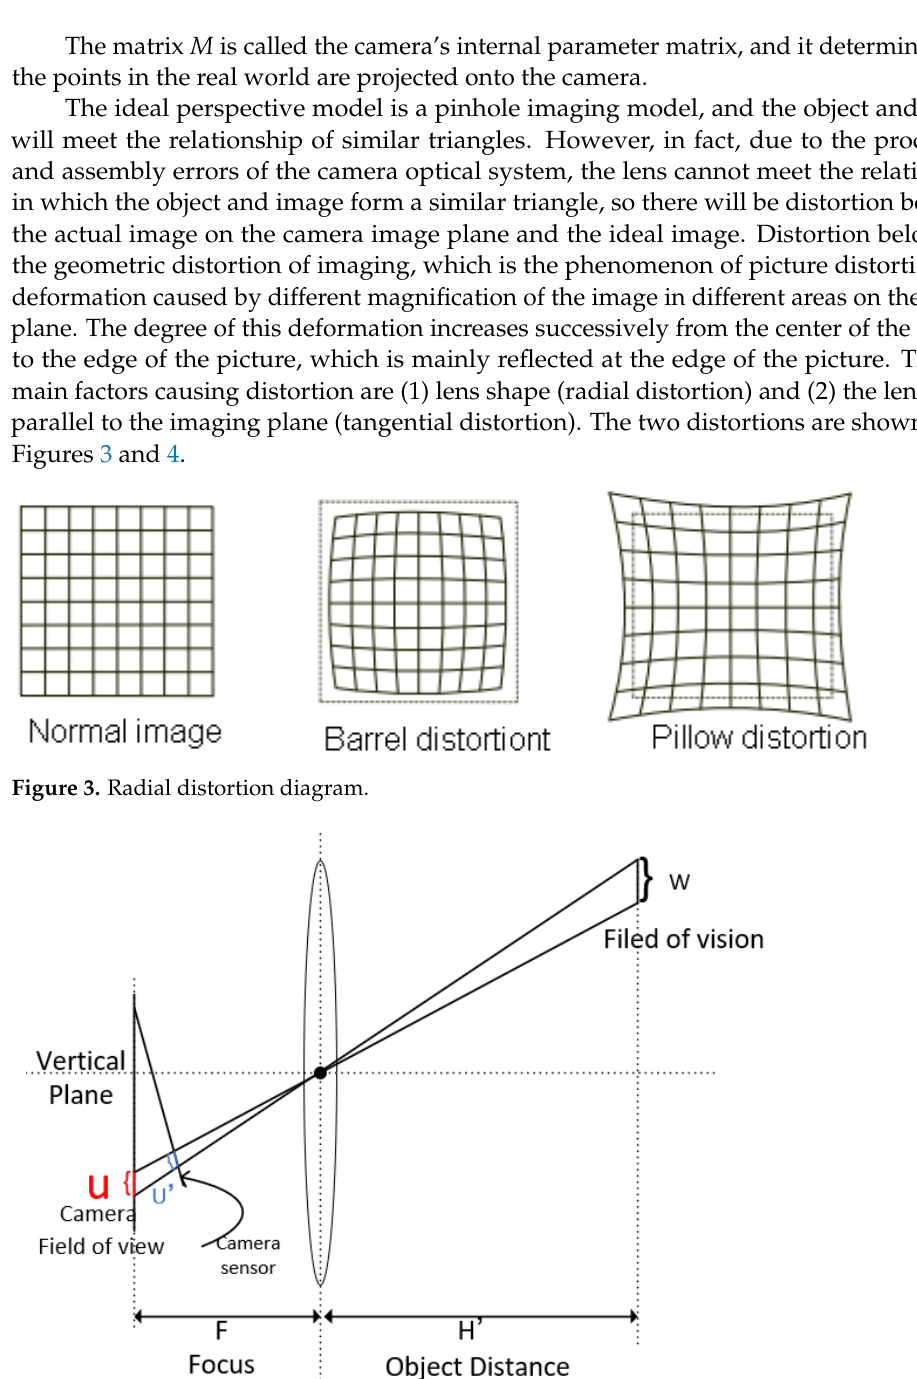
Figure 4. Tangential distortion diagram.